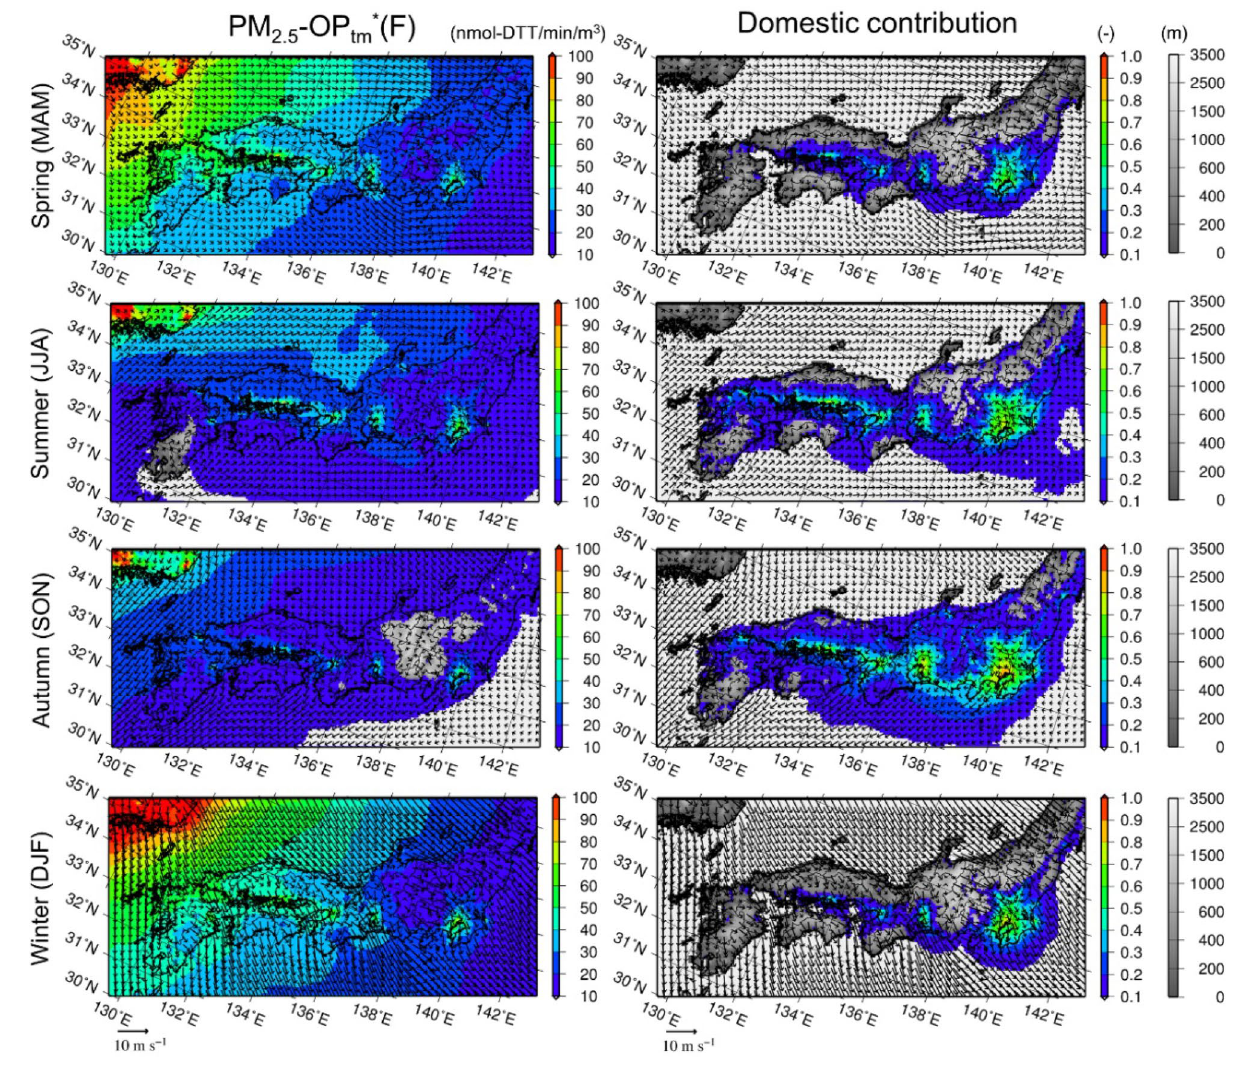
Figure 4. Seasonal mean surface anthropogenic PM 2.5 -OP tm *(F) and its domestic contributions. Seasonal mean (left) surface air concentrations of anthropogenic PM 2.5 -OP tm *(F) (nmol-DTT min −1 m −3 ) and (right) its domestic contributions over D02 in (top to bottom) the spring, summer, autumn, and winter of 2013. The model terrestrial elevations are depicted in grayscale under the various colors. The map was generated using the Generic Mapping Tools v4.5.7 (https:// www. gener ic- mappi ng- tools.